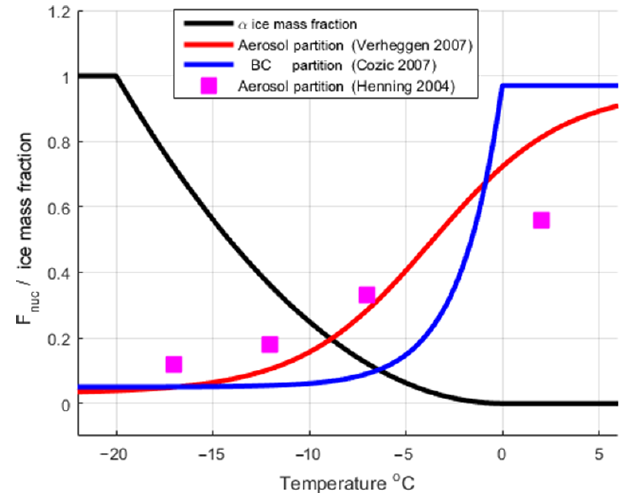
Figure 1. The fraction of cloud water that is in the ice phase ( α ) if CTWC is used (black line) and the fraction of aerosols that reside within cloud droplets ( F nuc ) (colored lines and dots) as a function of temperature. For F nuc , partitioning values for aerosol number from Verheggen et al. (2007) (red line), from Henning et al. (2004) (magenta dots) and from Cozic et al. (2007) (valid for black carbon (BC) particles) (blue line) are shown. For the BC partitioning, ice fraction was converted to temperature using α